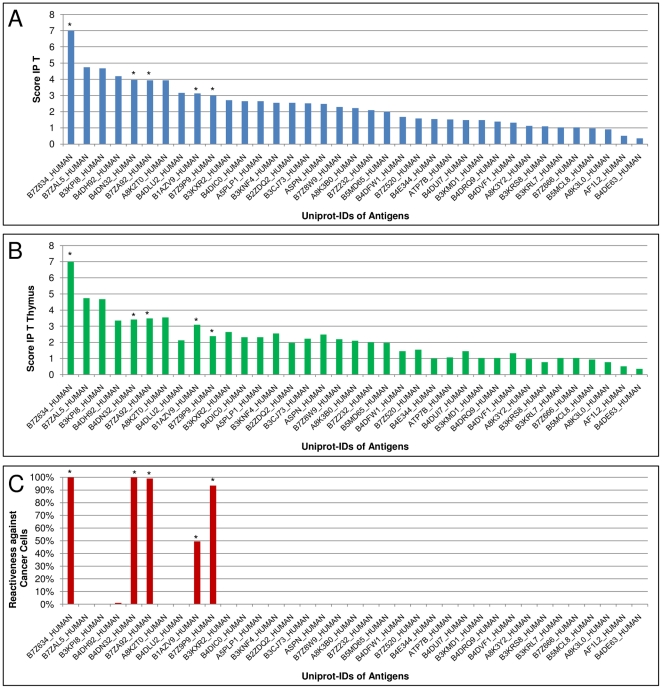
Comparison of IPT, Thymus Selection and Simulation.Scores for different antigens using IPT are compared with (A) a random sample of about 15,000 TCRs , (B) all TCRs from the set that survived the thymus selection and (C) with the reactiveness against cancer cells in the simulation with VaccImm. The antigens in all three diagrams are sorted by their IPT-score including all TCRs. Antigens inducing an immune response against the tumor, are marked with *. Simulation data were obtained from 100 simulations per column. The MHC-genotype is HLA_A02/HLA_DRB3. For all experiments one hundred initial cancer cells were simulated within 5 µl of blood that were treated with peptide injections starting at time point zero and being repeated five times at an interval of 28 days. The antigens were chosen from over-expression data in prostate tumors. One MHC I-binding peptide and one MHC II-binding peptide were injected.